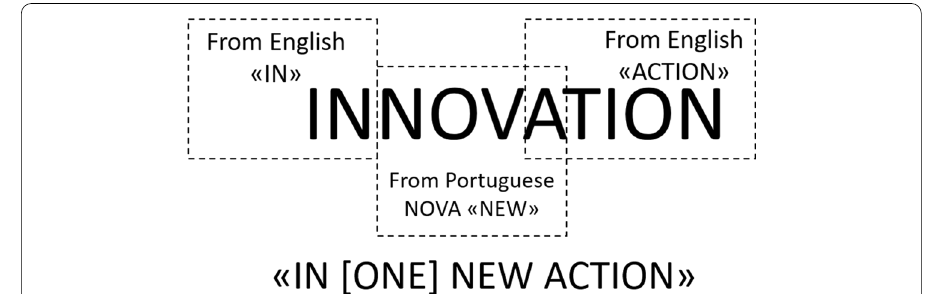
Fig. 2 Innovation (composed meaning). Proposed by Socorro (2017) in his book: Let’s talk about